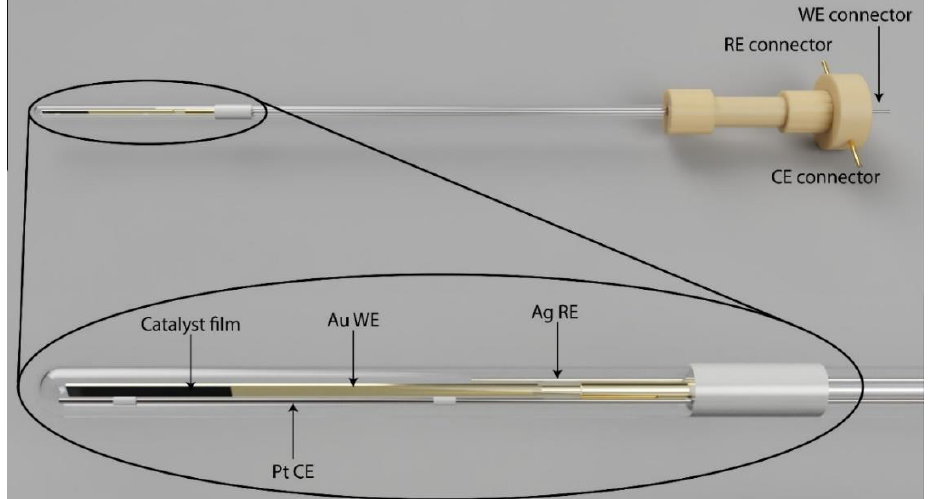
Figure 5. Scheme of the spectroelectrochemical cell (top) used in this study with a zoomed view of the electrodes (bottom). The cell was filled until the electrolyte reaches the reference electrode. Au WE refers to gold working electrode; Pt CE to platinum counter electrode and Ag RE, to silver reference electrode.